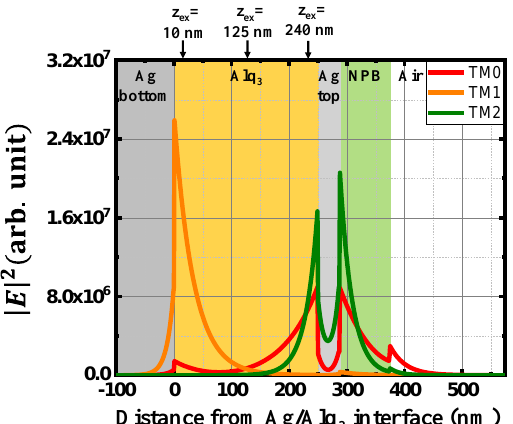
Table 1. Effective mode indices of TM modes obtained by the boundary mode analysis.